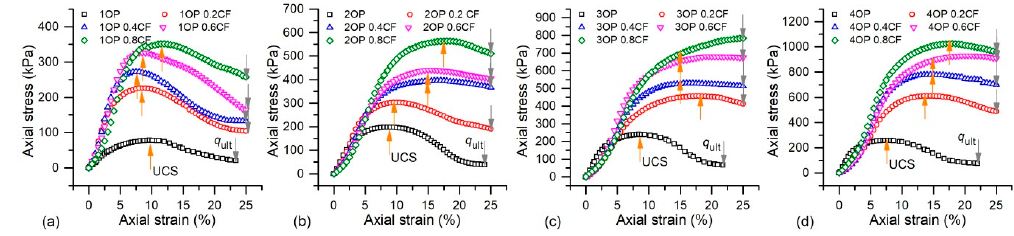
Figure 6. The axial stress-strain curves of OPSS and OPCFRS: ( a ) C op = 1%, ( b ) C op = 2%, ( c ) C op = 3%, and ( d ) C op = 4%.